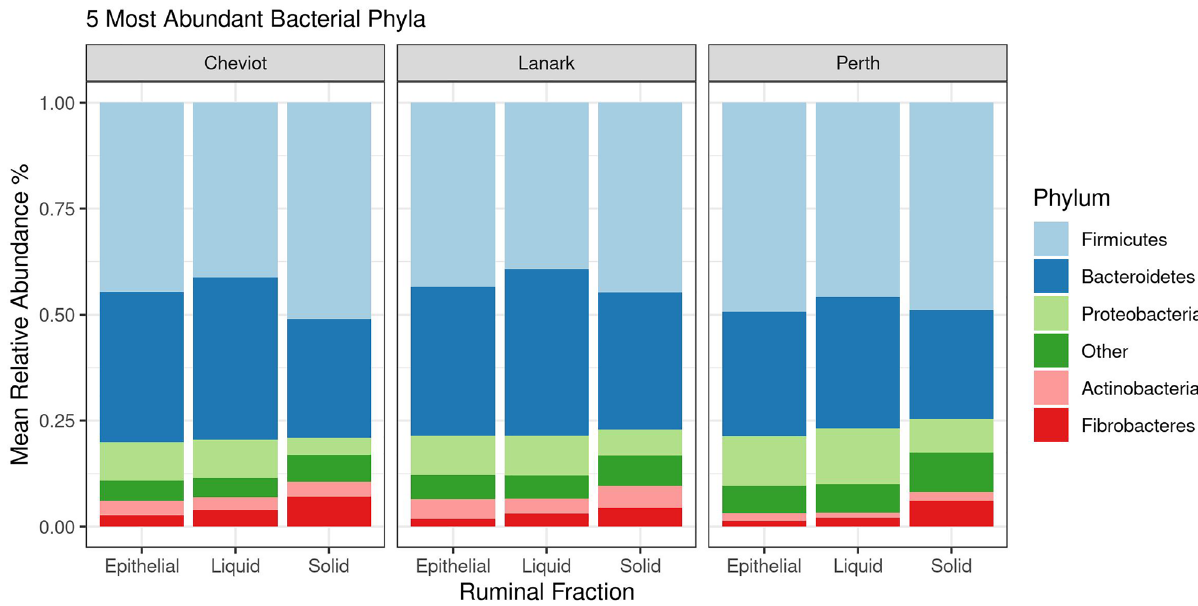
Figure 3. Stack barchart representing the mean relative abundance of the 5 most dominant phyla across ruminal fractions (i.e. solid, liquid and epithelial) for Cheviot, Lanark and Perth breeds. Cheviot (solid n = 7, liquid n = 5, epithelial n = 5), Lanark (solid n = 7, liquid n = 5, epithelial n = 5), Perth (solid n = 7, liquid n = 5, epithelial n =